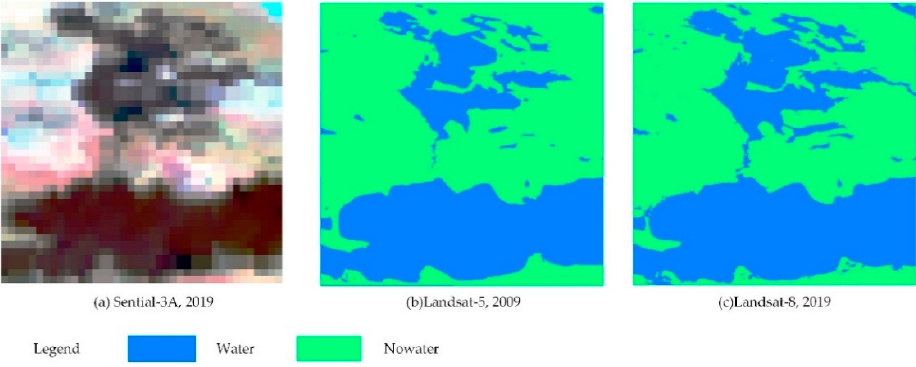
Figure 4. Data used in Experiment 1: ( a ) current Sentinel-3A OLIC image, 2019; ( b ) previous water body map (Landsat-5, 2009); ( c ) reference water body map (Landsat-8, 2019).